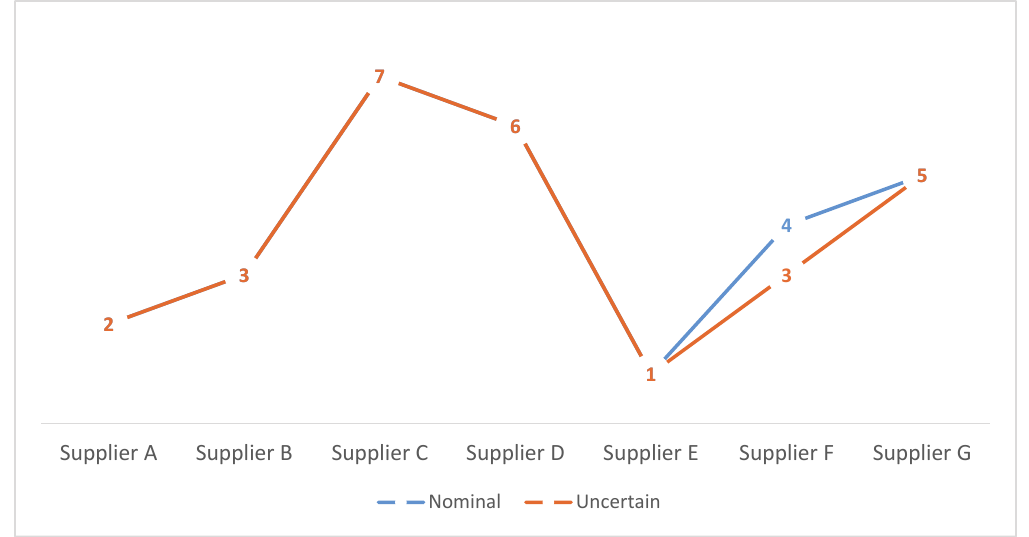
Fig. 5. The rankings of the alternatives in the nominal and the uncertain problem for